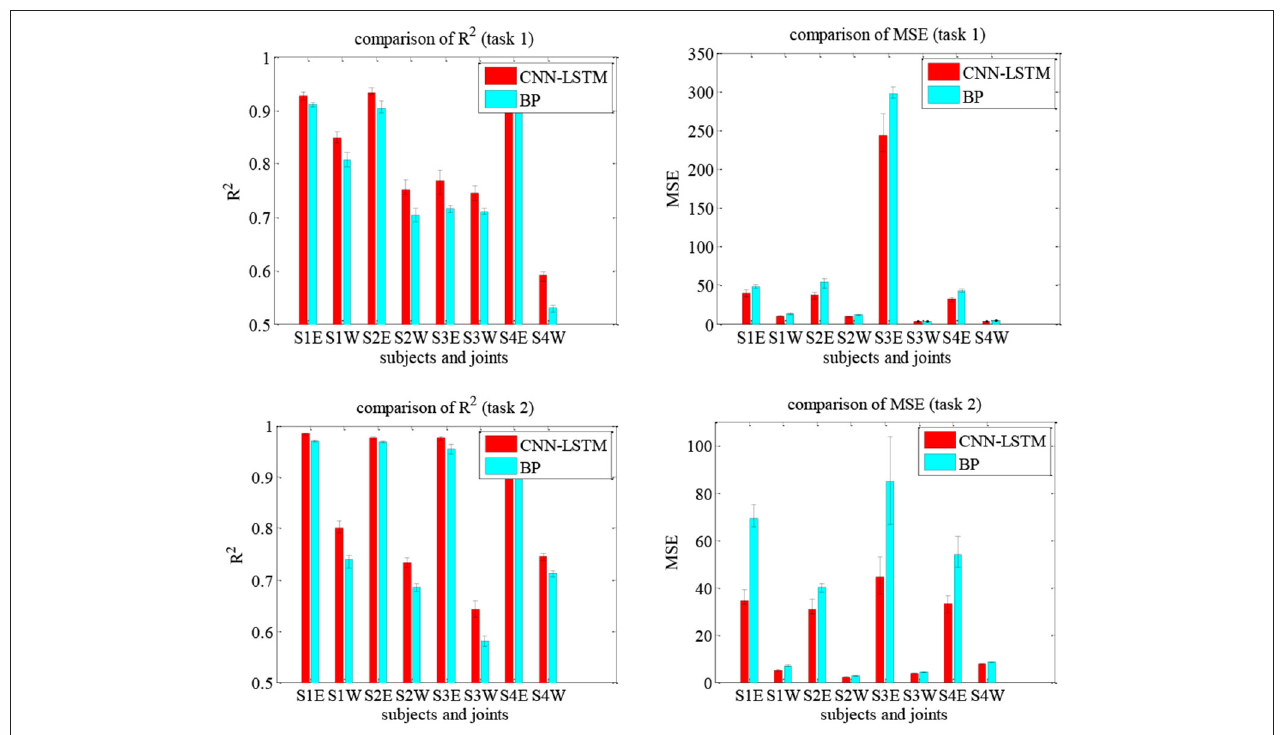
FIGURE 14 | Comparison of the effectiveness of the upper limb joints prediction using the CNN-LSTM and BP models under Tasks 1 and 2.